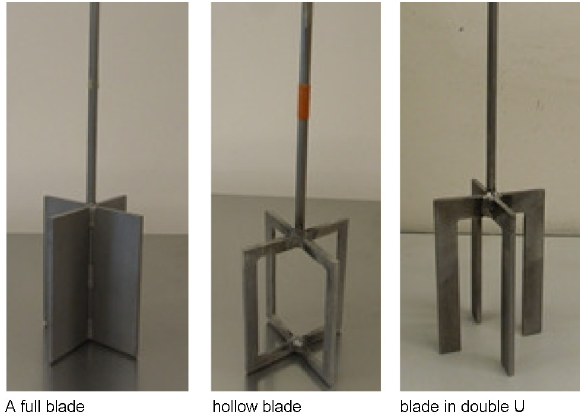
Fig. 10. The three tested blade